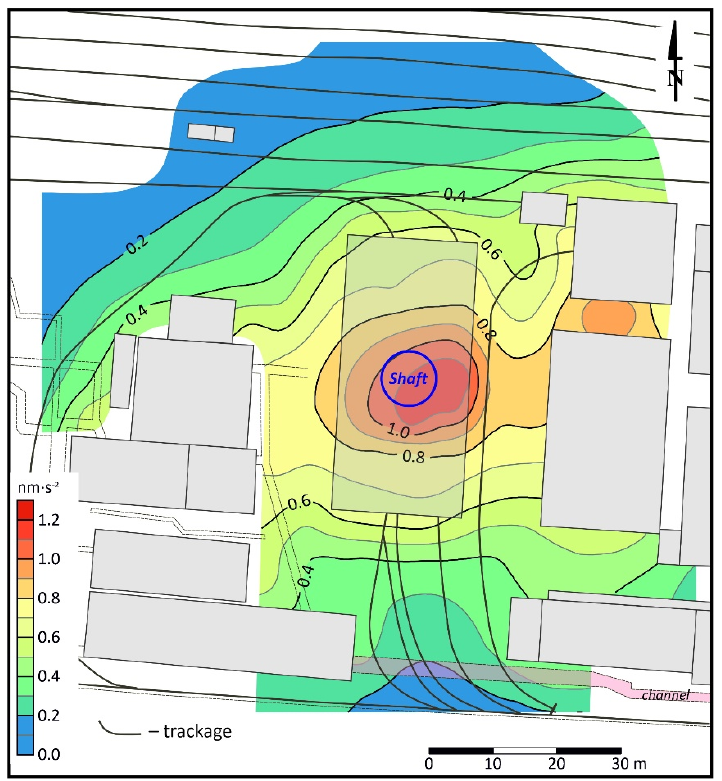
Figure 3. Distribution of the sum of building and mining correction.